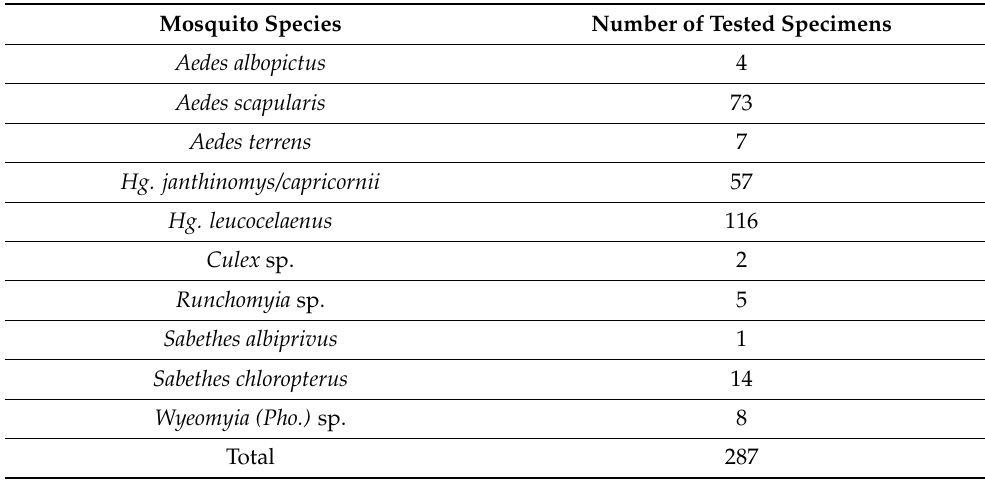
Table 6. Adult female mosquitoes screened for natural infection with YFV, all of which tested negative. Mosquitoes were collected with BG-Sentinel and protected human attraction at the Centro de Promatologia do Rio de Janeiro from December 2018 to December 2019. Mosquito Species Number of Tested Specimens Aedes albopictus Aedes